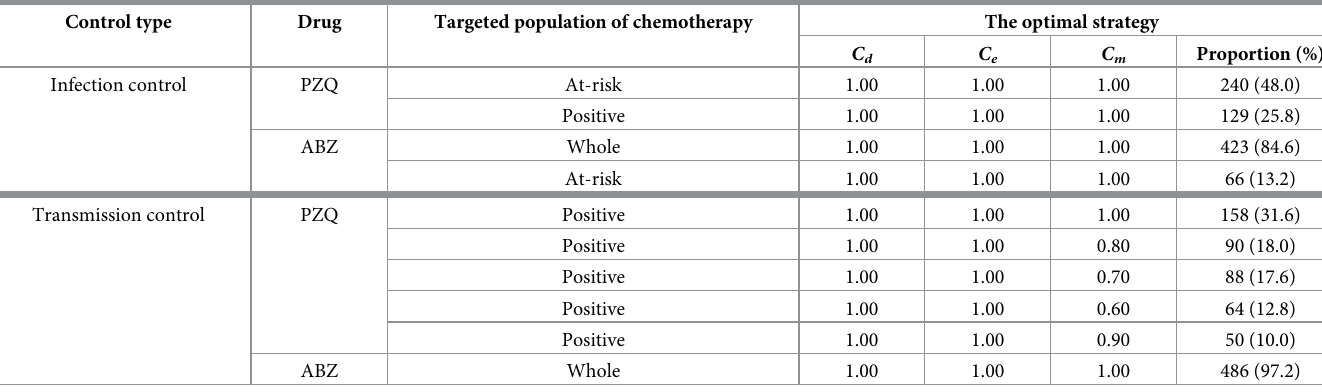
Table 2. The optimal cost-effective strategies for any targeted population of chemotherapy � . Control